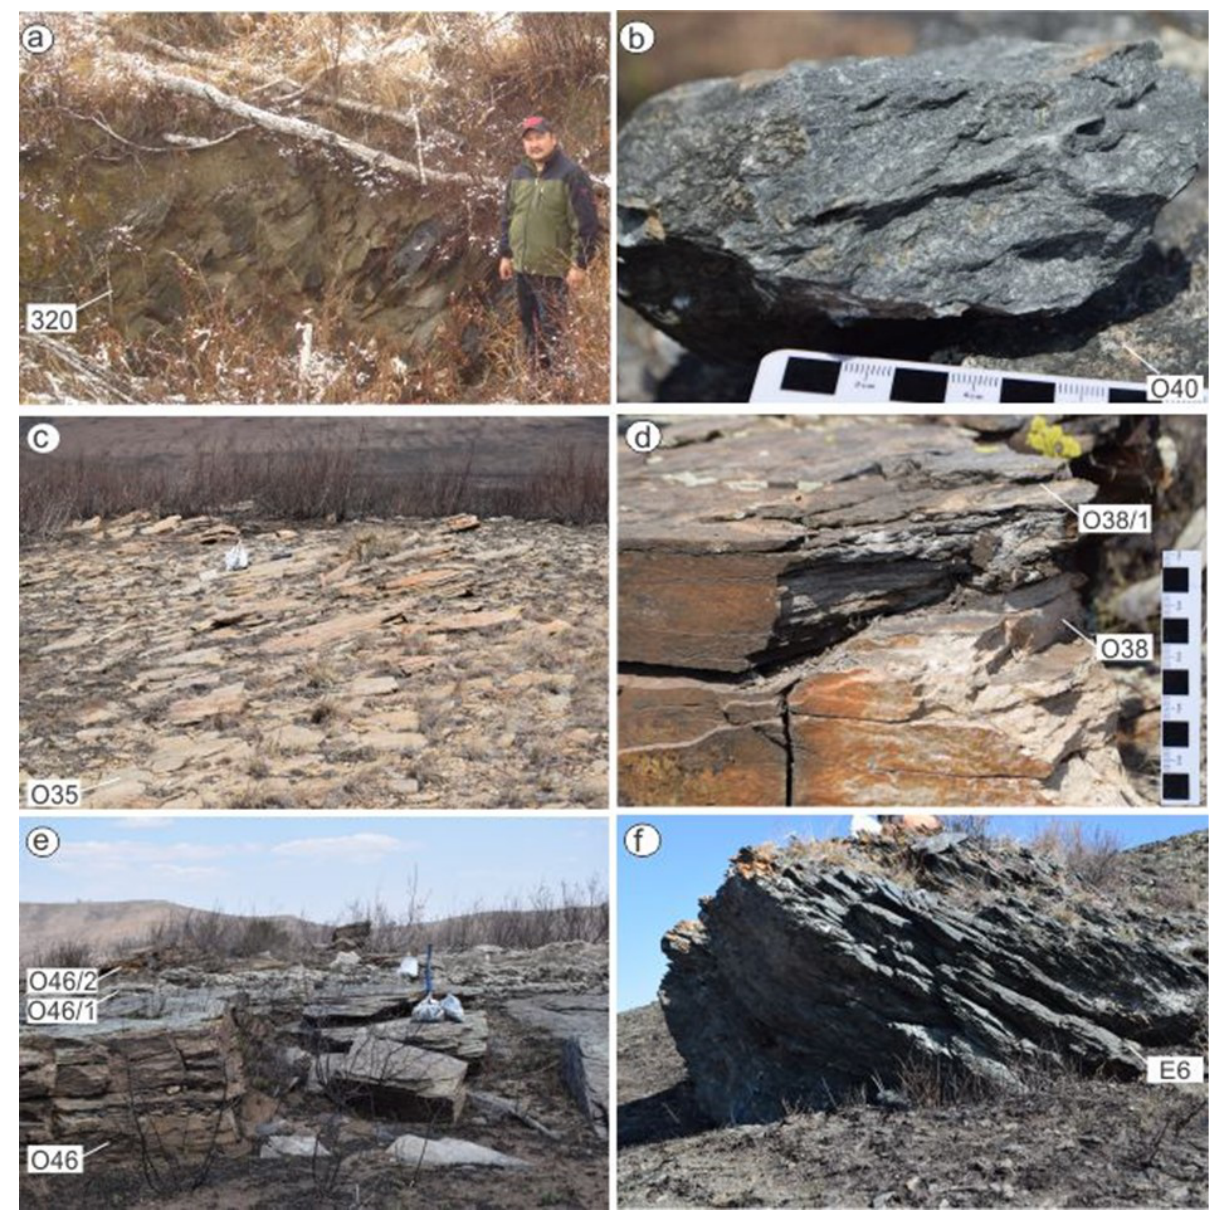
Fig. 2. Field photos of the typical metamorphic rocks of the Khaychingol and Ereendavaa Formations . a) Outcrops of black schist from Mogoitiin Gol area (sample 320). b) Hornblende schist (sample O40), c) Biotite-plagioclase gneiss (sample O35), d) Biotite-plagioclase gneiss (sample O38) and biotite-quartz-plagioclase schist (sample O38/1), and e) Two-mica quartz schist (sample O46), muscovite schist (sample O46/1) and biotite-plagioclase gneiss (sample O46/1) from Khaychin Gol area. f) Quartz-chlorite schist (sample E6) from Emgentiin Bulag